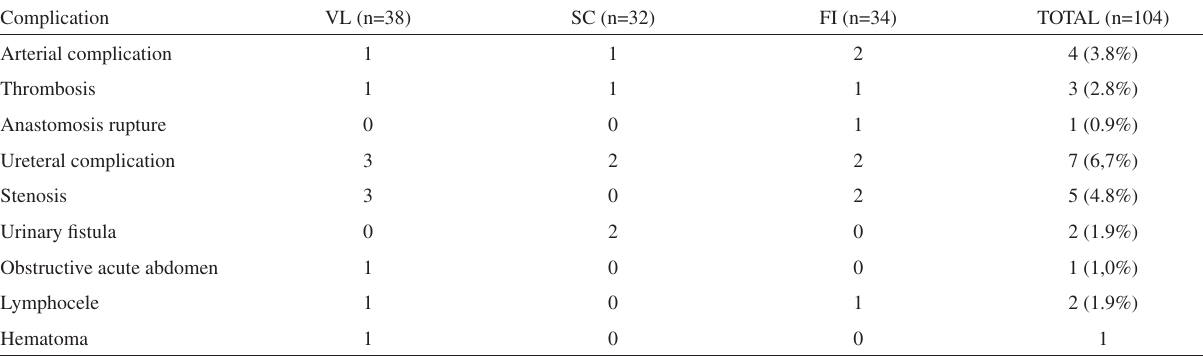
Table 3 - Incidence of recipient complications by surgical approach